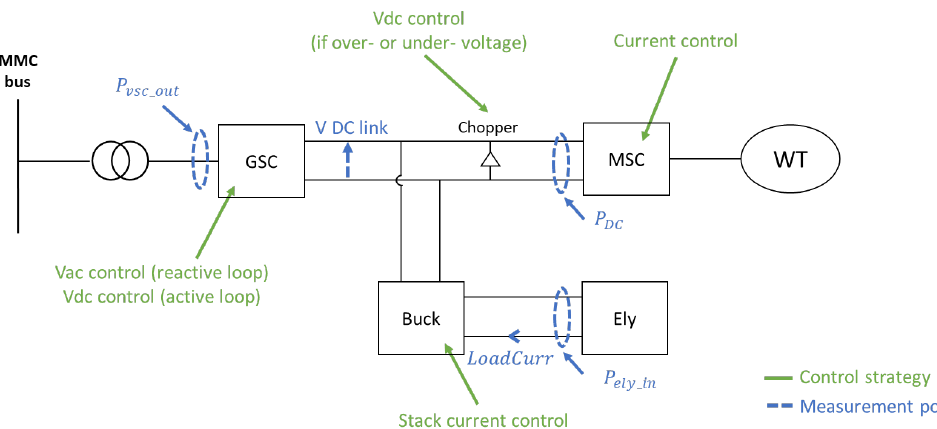
Figure 11. Control of the DC link of a wind turbine in Scenario 1. GSC = Grid Side Converter; MSC = Machine Side Converter; WT = Wind Turbine; Ely =